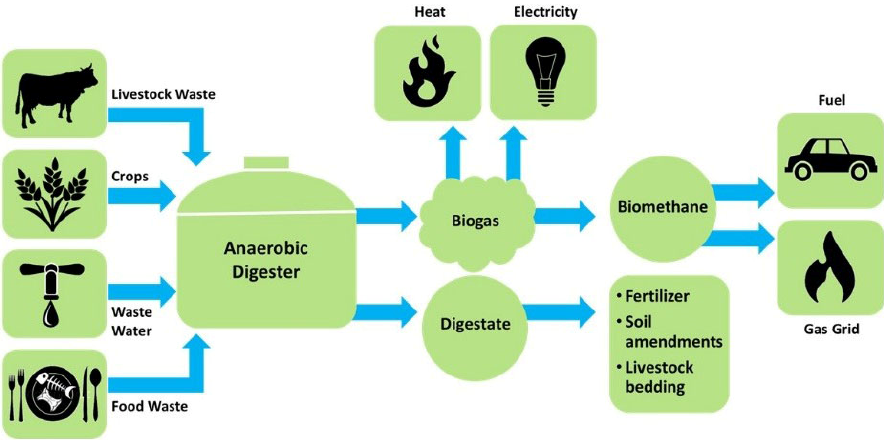
Figure 1. The material flow of the anaerobic digestion process and its uses [5].